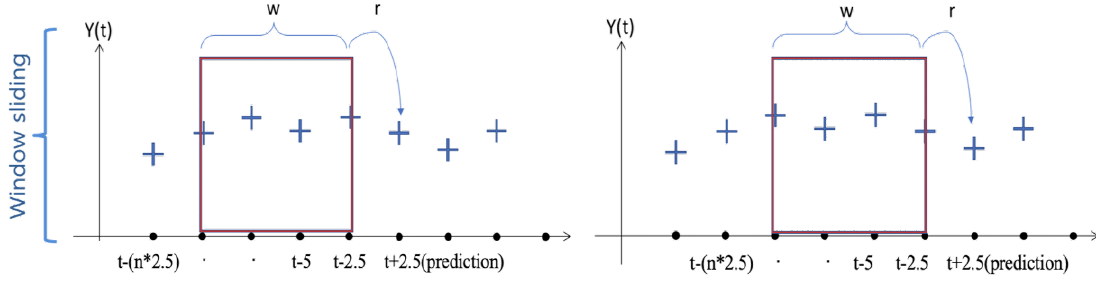
Figure 11. Target feature and prediction method .